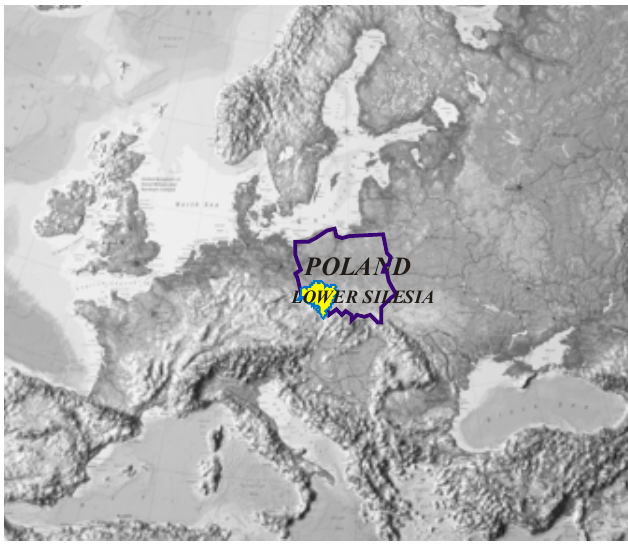
Figure 1. Location of Poland and the Lower Silesia region on the background of Europe. Source: Authors’ compilation.